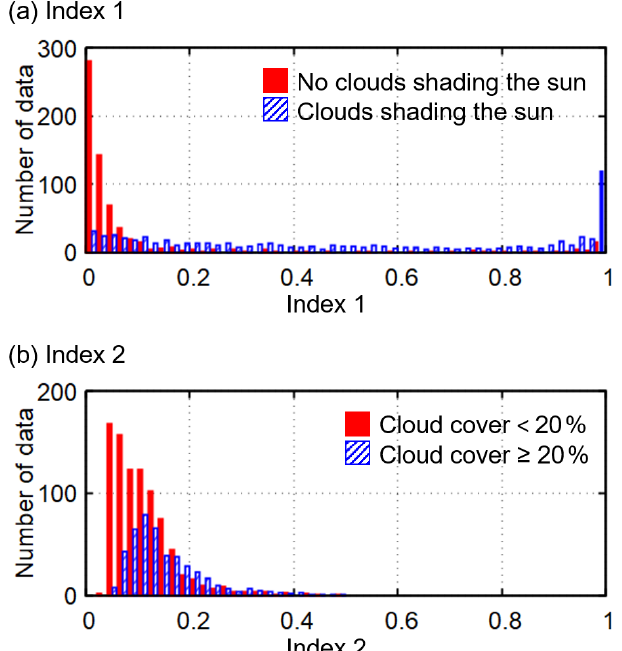
Figure 10. Histograms of indexes 1 and 2 of sky-radiometer obser- vations at Tsukuba. (a) Index 1 shows when the sun is covered by clouds (blue boxes) and not covered by clouds (red boxes). (b) In- dex 2 shows when cloud cover is less than to 20% (red boxes) and greater than or equal to 20% (blue boxes).